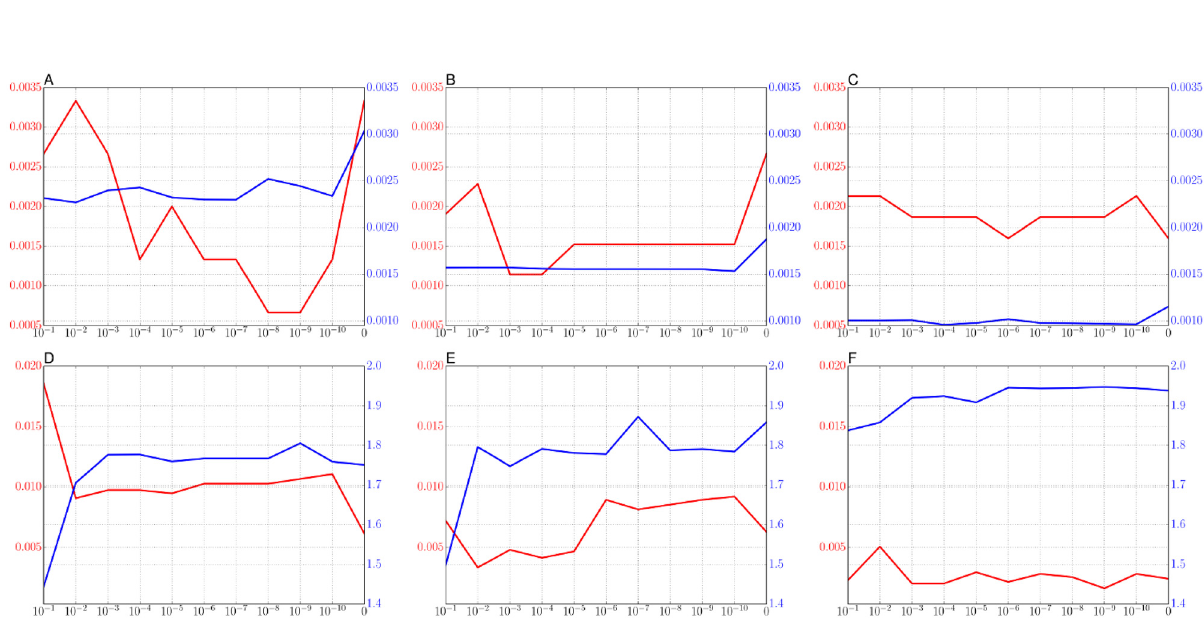
Fig 3. The trends of the optimized objective values with respect to the weighting factor. (A-C) The trends of the hard objective on A1, A2, and A3 of the A-sets. (D-F) The trends of the soft objective on S1, S2, and S3 of the S-sets. The horizontal axis shows the weighting factor λ and the vertical axis shows the main objective term and the regularization term. The red line shows the main objective values and the blue line shows the regularization value without weighting by λ shown in Eq (14).